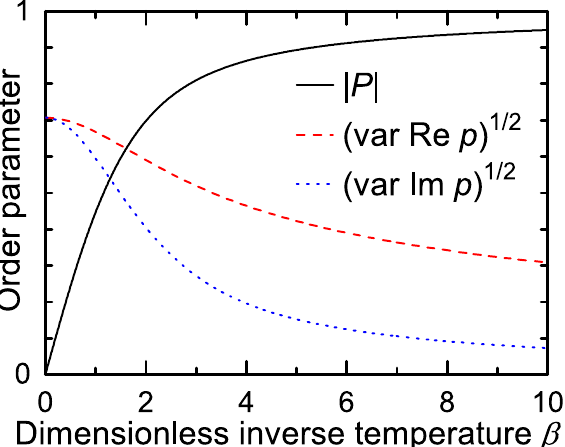
Figure 3. Characterization of local order p as function of dimensionless inverse temperature β ⋆ : | P | (black line), R p Var (red dashed line) and { } (cid:31)